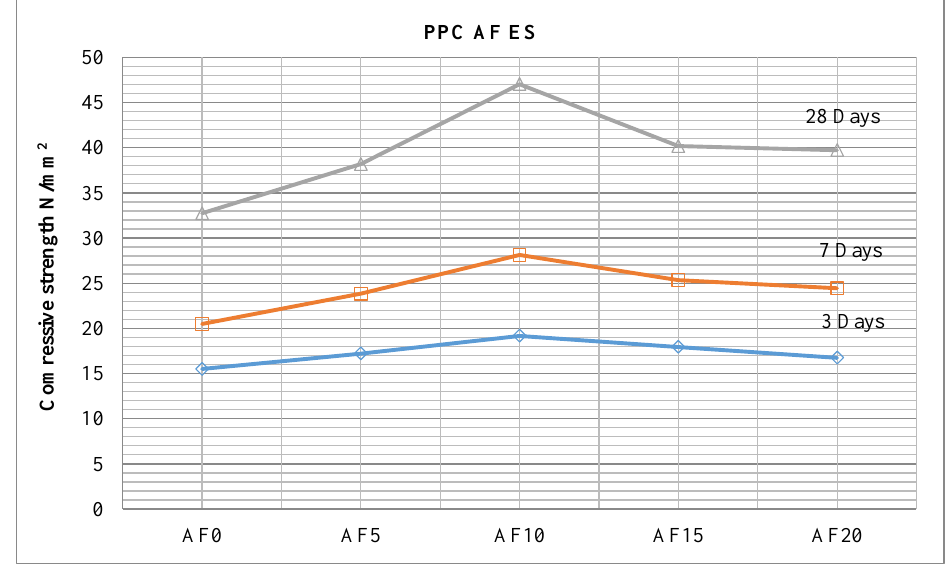
Figure 15. Mortar cube compression strength at different